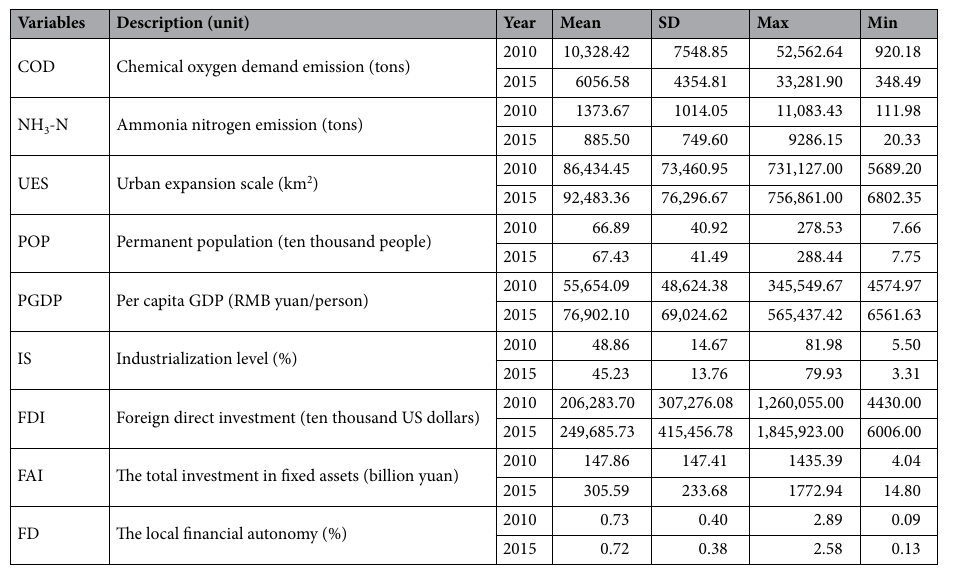
Table 1. Descriptive statistics of the main